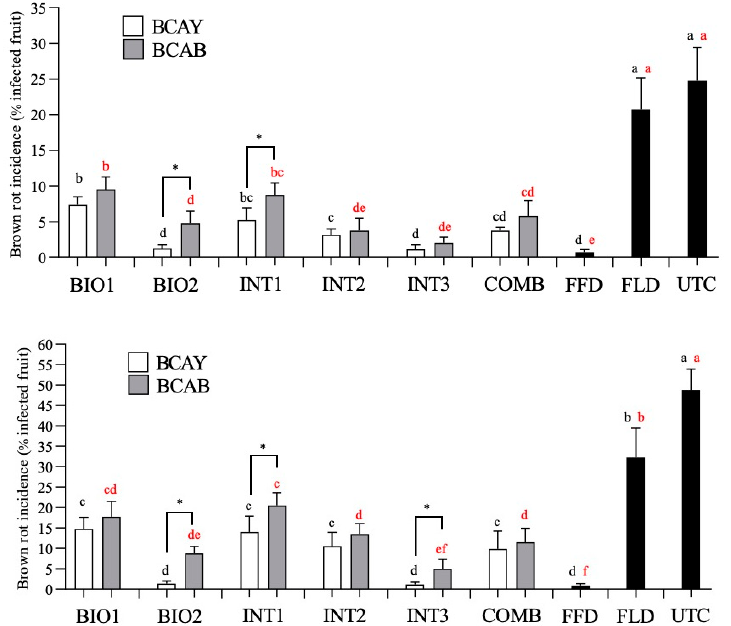
Figure 2. Brown rot incidence on plum fruits assessed in two consecutive years (year 1 and year 2) of field trials in which the plants in plum orchard were treated following six different disease management strategies: Biological, in which the BCAs (the yeast Papiliotrema terrestris PT22AV (BCAY) or the commercial biofungicide Serenade Max ® based on Bacillus subtilis strain QST 713 (BCAB)), were applied alone in five (BIO1) or seven (BIO2) consecutive treatments; Integrated, i.e., INT1, INT2 and INT3, consisted of the application from the beginning of the growing season of one, two or three treatments respectively, with the chemical fungicides boscalid or cyprodinil applied alternately and each strategy was followed by BCAs applications until fruit harvest; Combined (COMB), in which the biocontrol yeast PT22AV or Serenade Max ® were applied in combination with a low dose (25% of the full label dose) of the synthetic fungicides Cantus ® or Chorus ® (alternately) in all treatments; Chemical, in which the chemical fungicides Cantus ® and Chorus ® were alternately applied at low (25% of full dose) (FLD) or at full label dose (FFD) in all treatments. For each BCA (BCAY or BCAB) and for each year, means showing different letters or marked with an asterisk are significantly different according to Tukey’s multiple comparison test ( p < 0.05) and Uncorrected Fisher’s LSD comparison test ( p < 0.05),